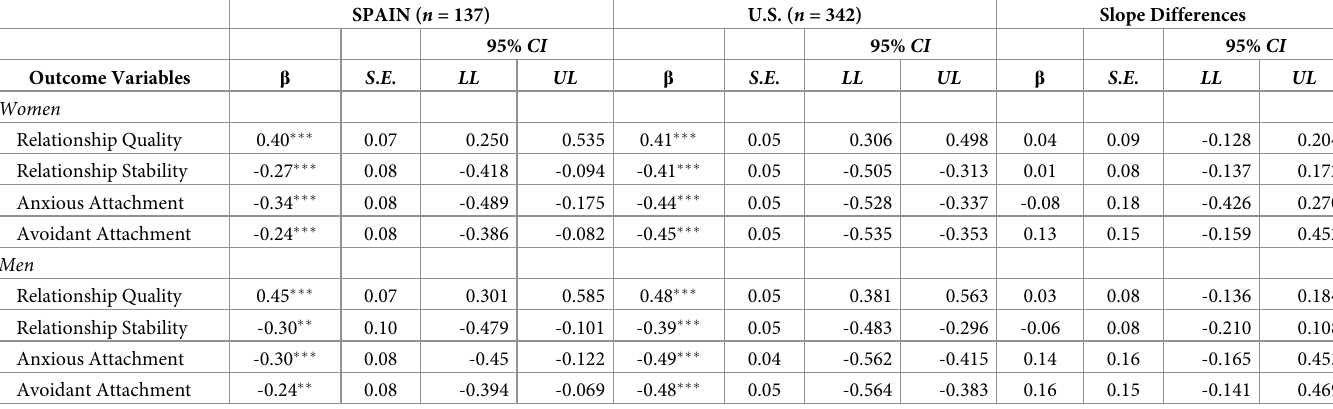
Table 4. Regression effects of women and men Time 2 combined differentiation of self scores on Time 2 outcome variables for couples from Spain and the U.S., and cultural differences among the